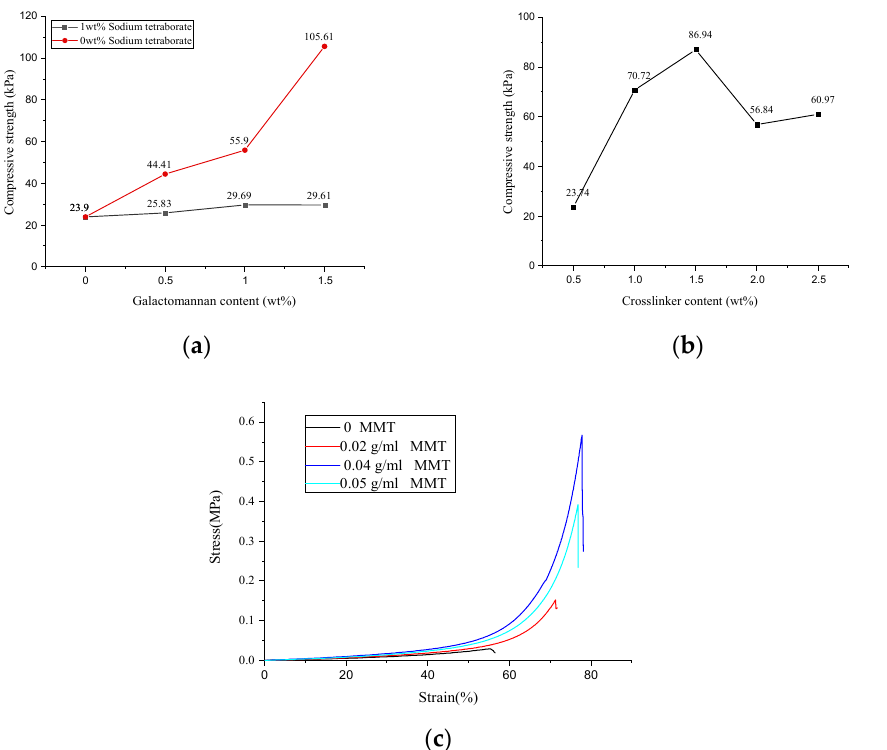
Figure 3. Mechanical strengths of the GA–P(NIPAM ‐ co ‐ DMAPMA) hydrogels with ( a ) different GA contents and ( b ) crosslinking agent contents. ( c ) Hydrogel compression stress–strain curves for different montmorillonite contents.